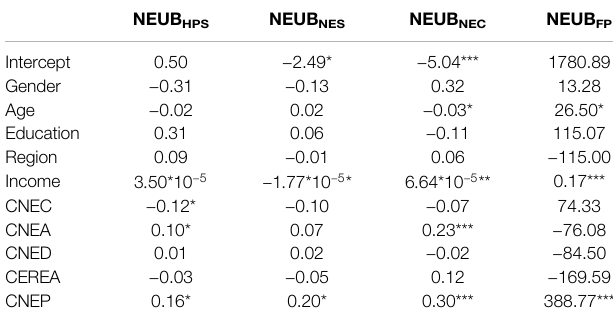
TABLE 4 | Regression coef fi cients analysis of NEUB HPS , NEUB NES , NEUB NEC , and NEUB FP